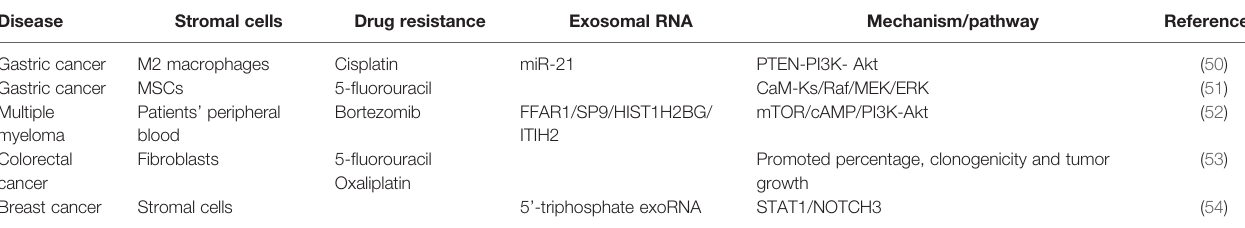
TABLE 2 | Signal transmission between stromal cells and tumor cells.